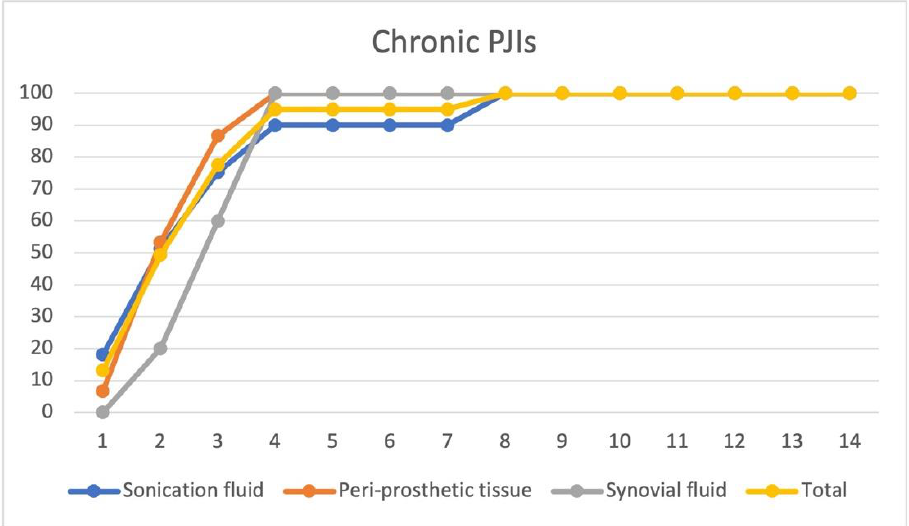
Figure 3. Time to positivity for bacterial cultures for chronic PJI cultures. Time to positivity plotted against the percentage of culture positivity in chronic (n = 33 patients) PJIs as a total (from all clinical samples), and from different clinical samples (sonication fluid cultures, periprosthetic tissue cultures, and synovial fluid cultures). On the vertical axis—culture positivity (%), and on the horizontal axis—time to positivity (days).